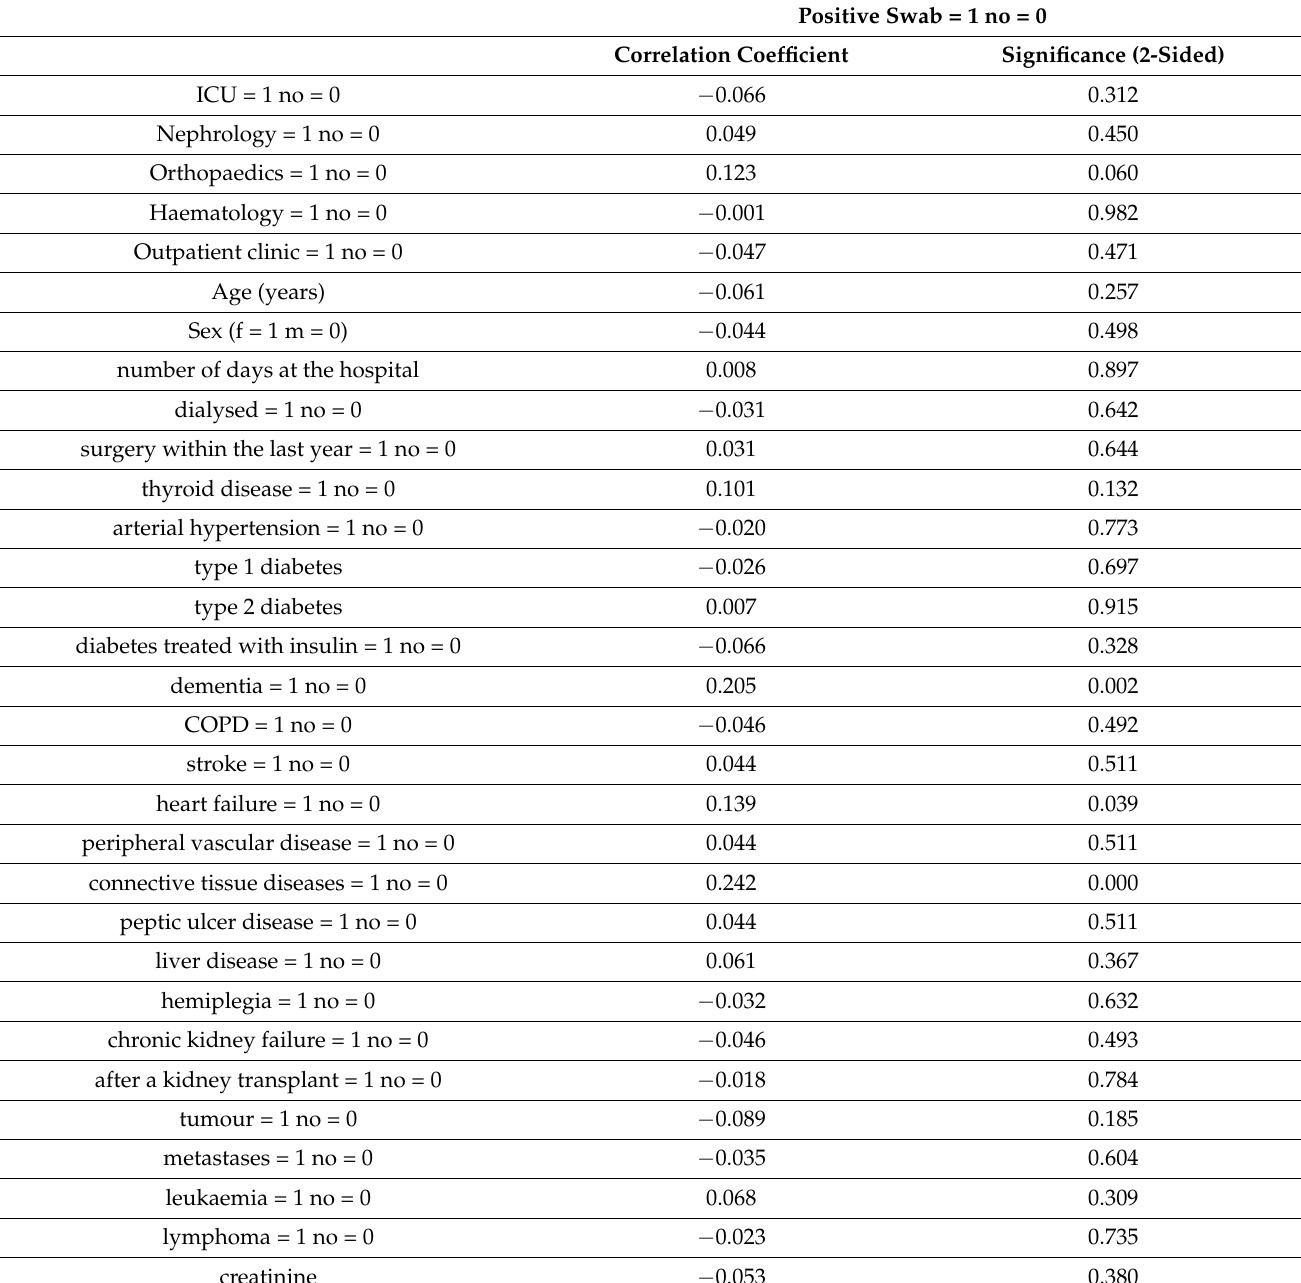
Table 6. The strength of relationship between the studied factors and the positive swab category based on a Kendall’s tau-B correlation